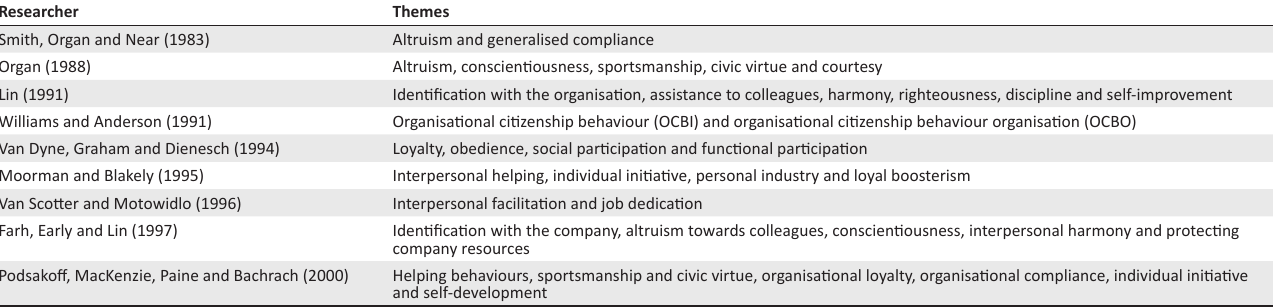
TABLE 1: The dominant themes of organisational citizenship behaviour.